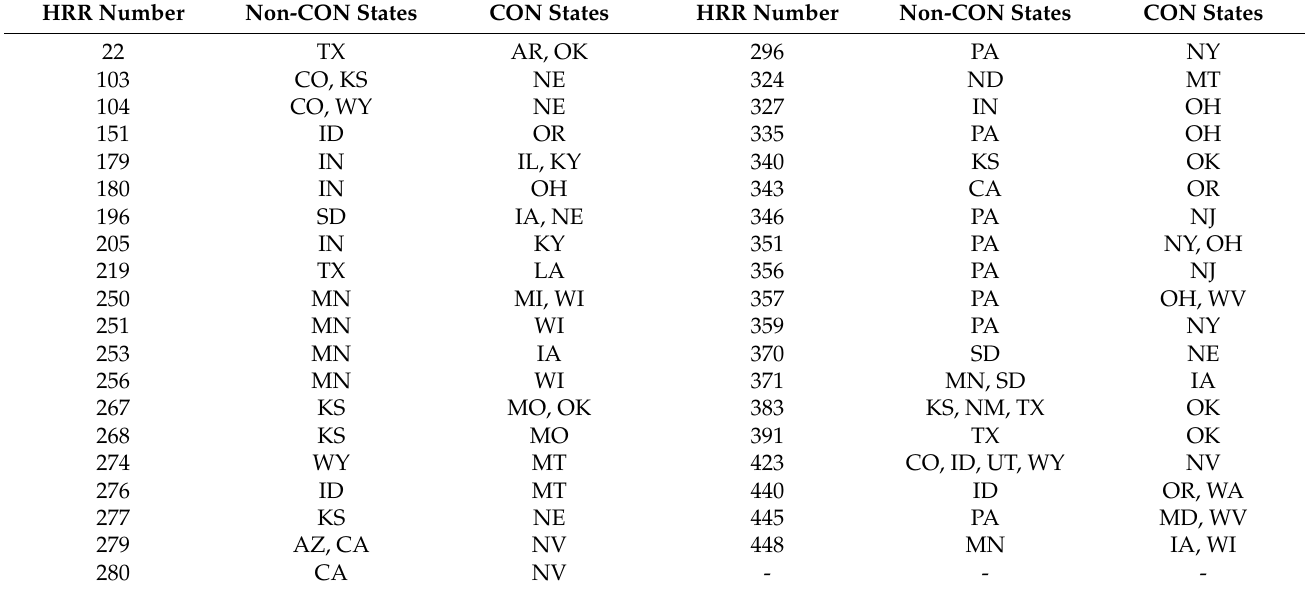
Table 2. HRRs that crossed the borders of states with and without CON laws (2011).